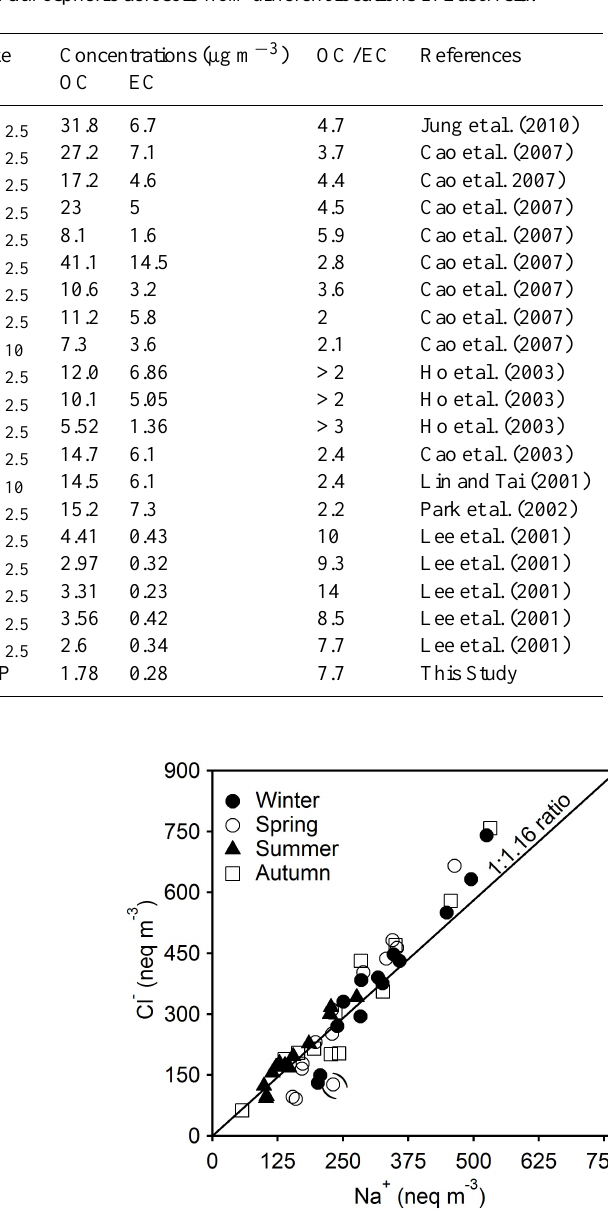
Fig. 10. Scatter plot showing variation of Na + and Cl − with respect to sea water line in ambient aerosols collected from Cape Hedo, Ok- inawa. The point within the bracket shows the maximum chlorine loss.